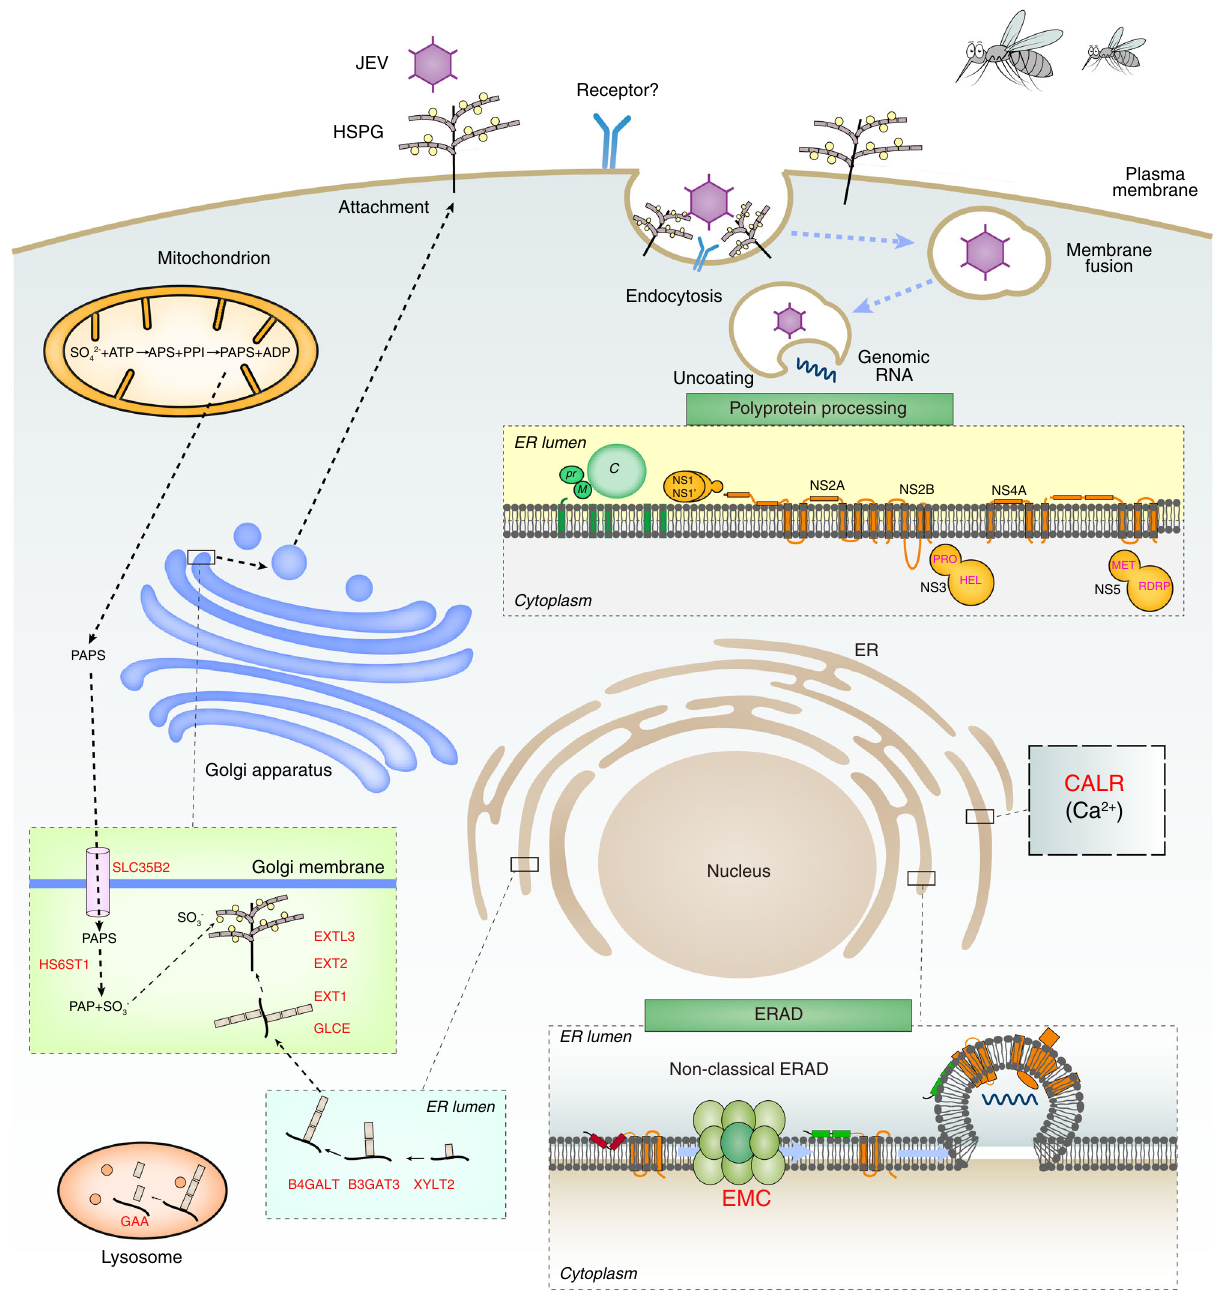
Fig. 7 A proposed model for JEV entry and replication in porcine cells. The JEV-infection cycle starts with binding to co-factors HSPGs, and/or unknown cellular receptors, followed by viral entry to enable replication. The EMC complex protein (EMC3 and EMC6) and CALR calcium-binding protein of the ER lumen are involved in JEV replication of host cells. Subsequently, the JEV RNA genome is replicated, viral particles are matured and packaged, and are released from cells. JEV, Japanese encephalitis virus; HSPG, heparan sulfate proteoglycan; PAPS, 3 ′ -Phosphoadenosine-5 ′ -phosphosulfate; PAP, 3 ′ - phosphoadenosine-5 ′ -phosphate; ATP, Adenosine triphosphate; ADP, Adenosine diphosphate; APS, Adenosine 5 ′ phosphosulfate; PPI, pyrophosphate; ER, endoplasmic reticulum; ERAD, endoplasmic reticulum-associated protein degradation; EMC, endoplasmic reticulum membrane protein